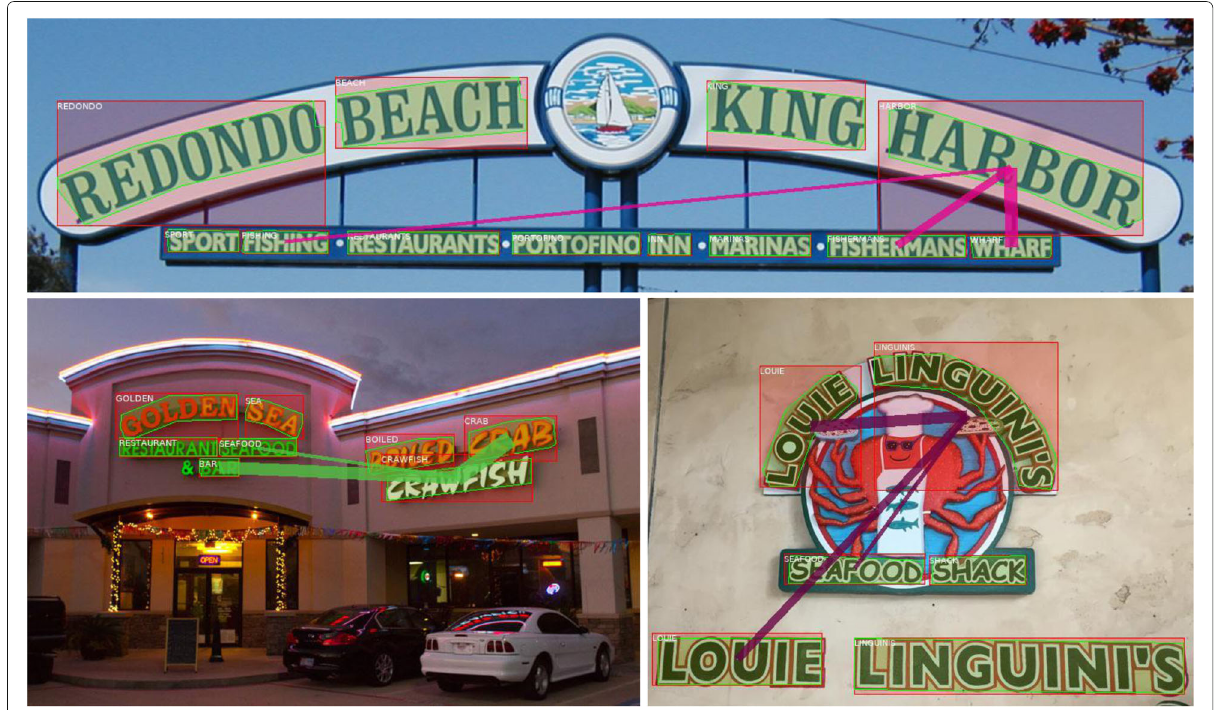
Fig. 7 Visualization of results from our text spotting model with edges learned by TRN